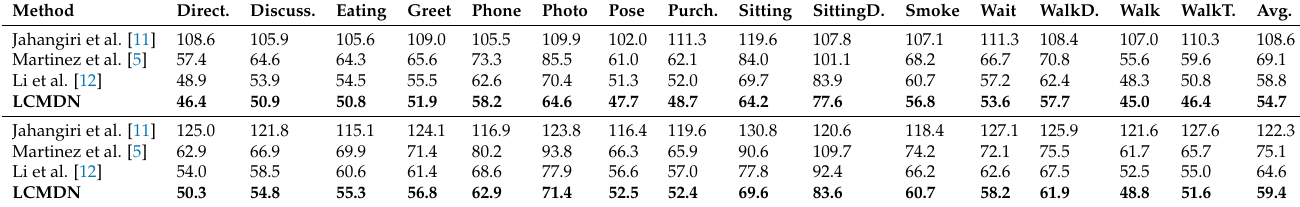
Table 2. Results of missing joints and comparisons. The first three rows show the results of one missing joint, and the last three rows show the results of two missing joints. (Best result in